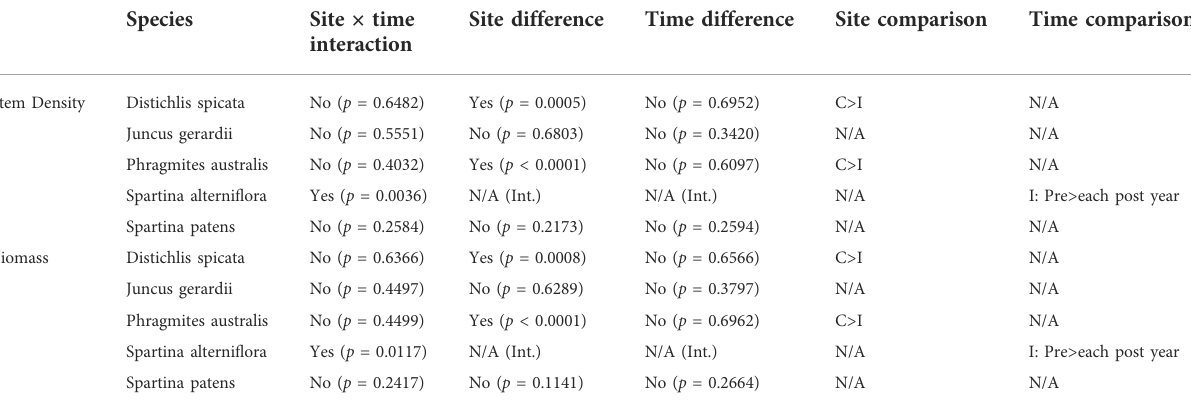
TABLE 3 Two-factor ANOVA main effects and site × time interactions examining stem count and estimated biomass for species (as indicated), using transect mean percent cover values.